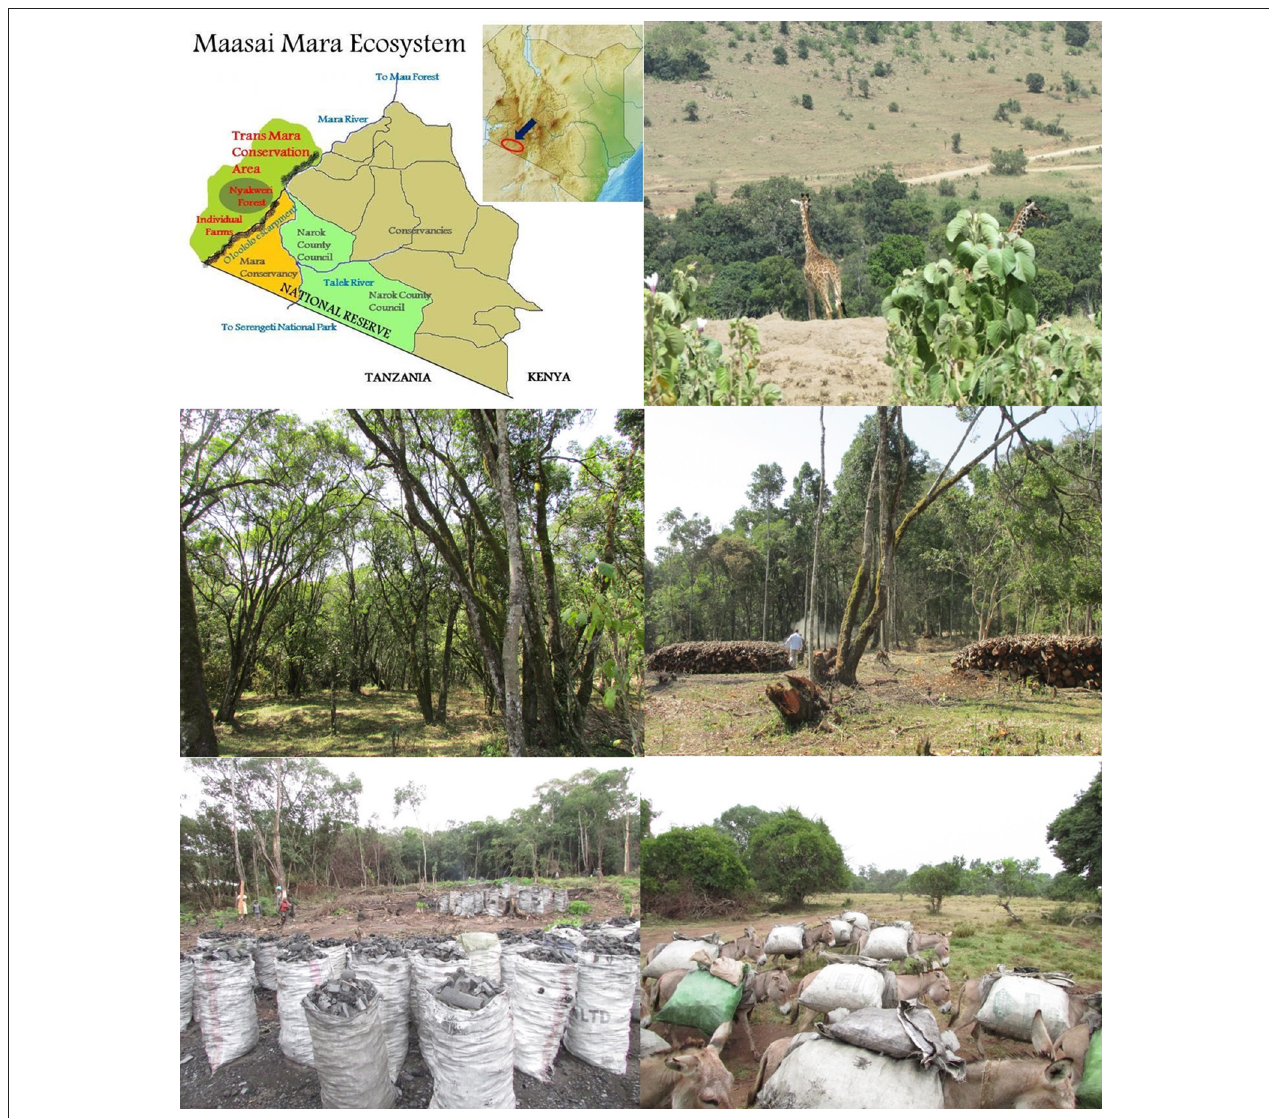
FIGURE 2 | Kenyan site illustration. Over the escarpment of the Mara Triangle lies Trans Mara Conservation Area encompassing recently sub-divided farms and Nyakweri Forest. Indigenous forests have provided multiple ecosystem services over and beyond the Mara Ecosystem. However, trees are felled for agriculture with charcoal produced as a